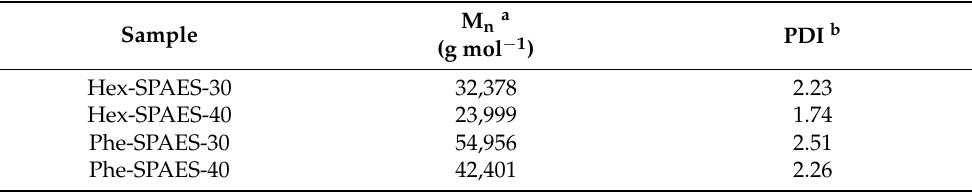
Table 1. Molecular weights of the synthetic polymer